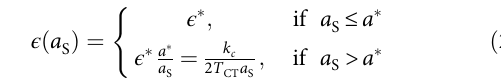
when symptomatic C . C = r NA for C C fi c